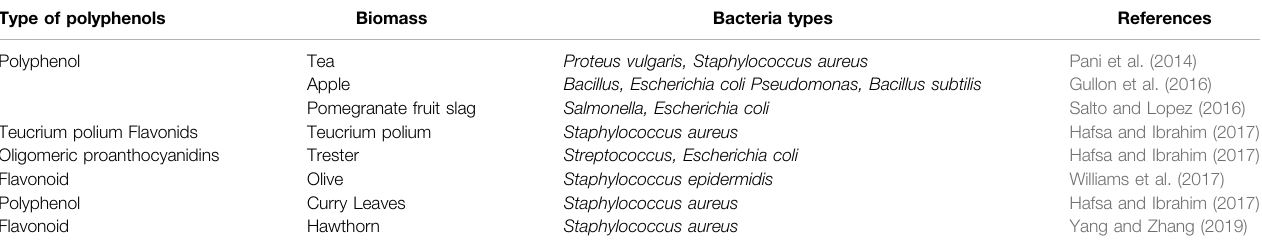
TABLE 2 | Antibacterial effect of different